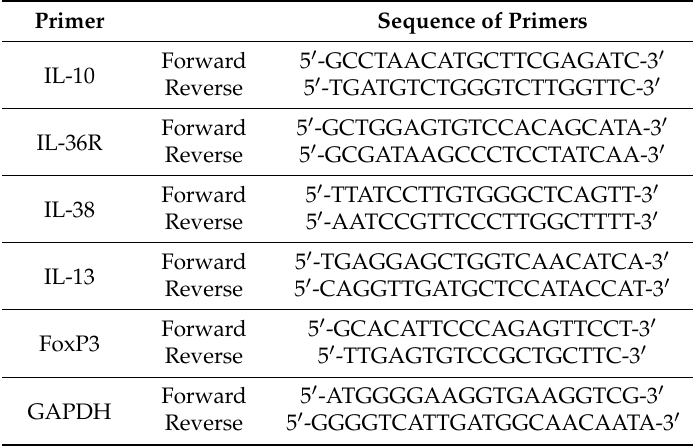
Table 3. Primers for different human genes used in real time